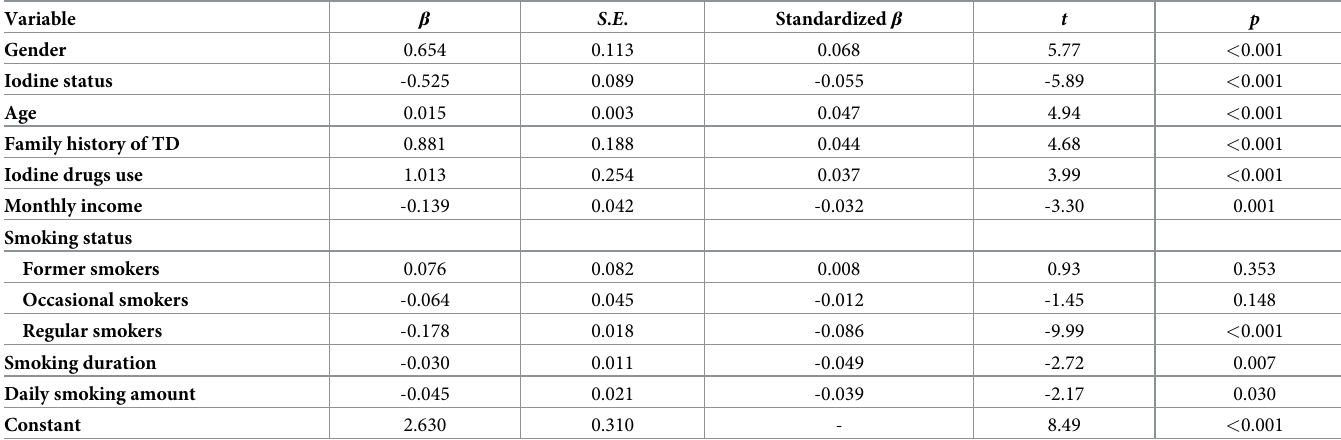
Table 4. Multivariate analysis of factors related to Ln